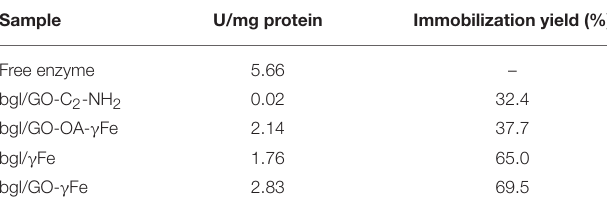
TABLE 2 | Activity of free and immobilized bgl and immobilization yield (%) of bgl, calculated as the concentration ratio of protein immobilized on nanomaterials to the initial protein quantity used (standard deviation was less than 3% in all